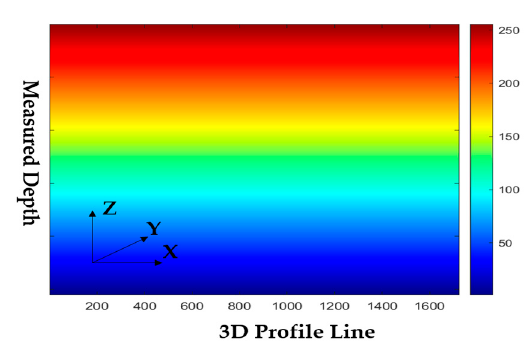
Figure 3. Schematic diagram of line-scanning chromatic confocal measurement.